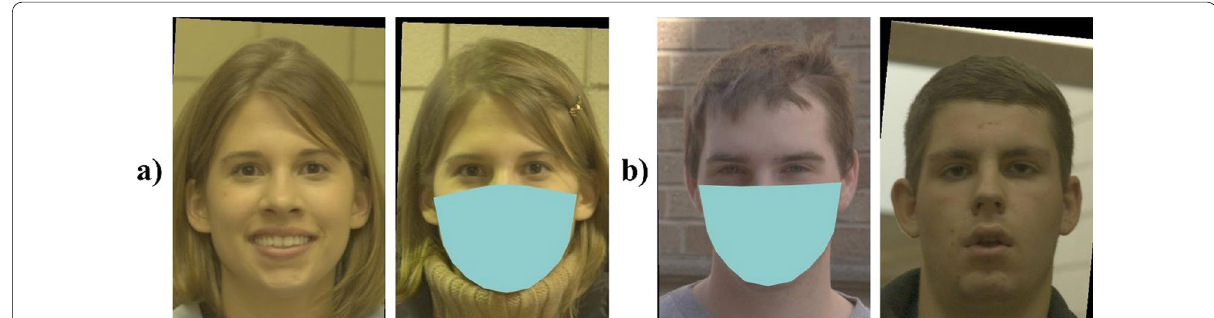
Fig. 1 Examples of a match and b mismatch trials from the EFCT. Participants responded to the question “ Is the same person shown in both photographs? ” using 6 possible responses: “ Definitely Not ”, “ Probably Not ”, “ Guess Not ”, “ Guess Yes ”, “ Probably Yes ”, and “ Definitely Yes